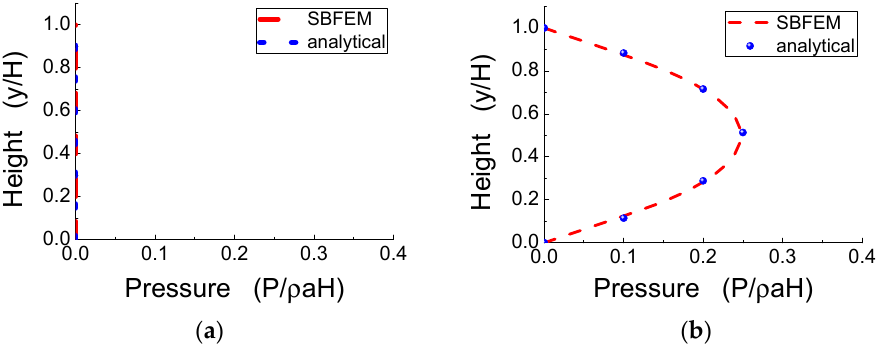
Figure 15. Triangular valley with transverse excitation: ( a ) along line AB and ( b ) along line AC.